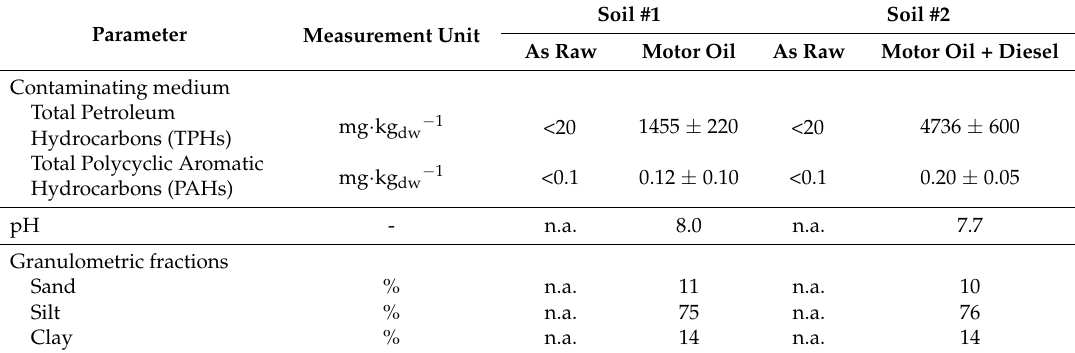
Table 1. Characteristics of the soils treated by wet